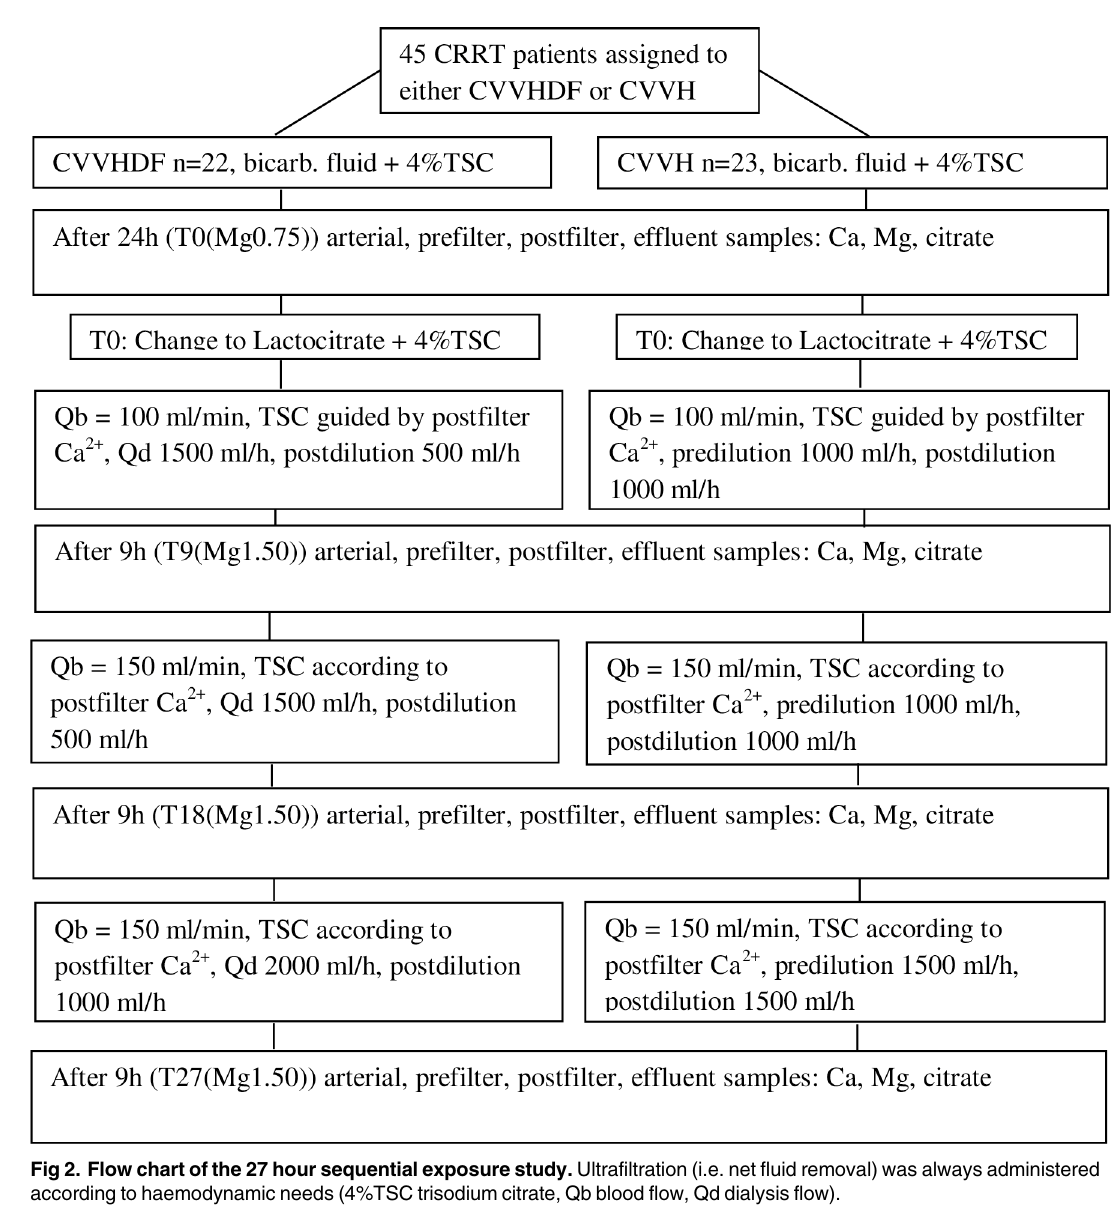
Fig 2. Flow chart of the 27 hour sequential exposure study. Ultrafiltration (i.e. net fluid removal) was always administered according to haemodynamic needs (4%TSC trisodium citrate, Qb blood flow, Qd dialysis flow).